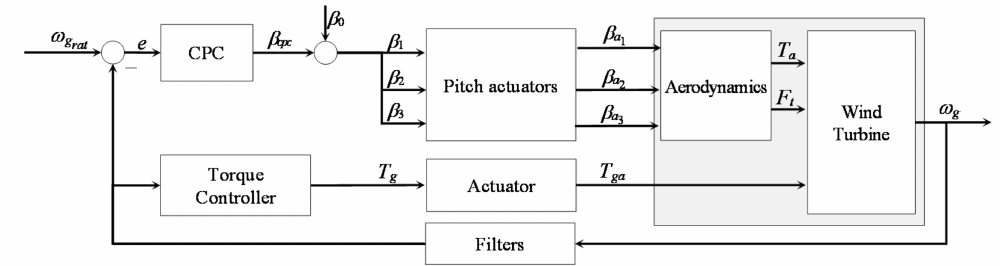
Figure 2. Collective pitch control system, including the torque control